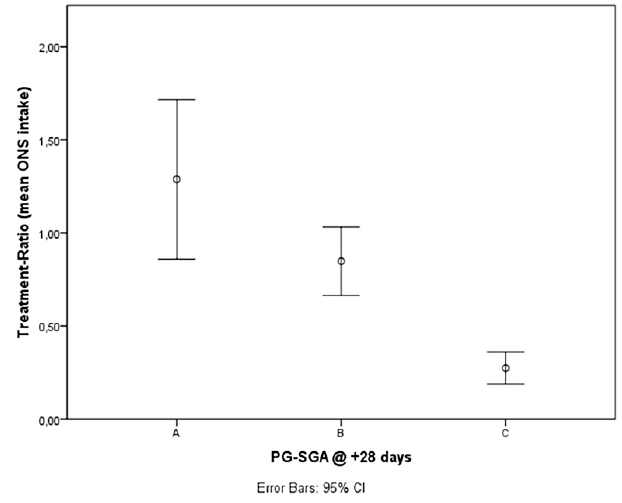
Figure 2. Mean TE-OPF assumption and malnutrition categories according to PG-SGA at 28 days after transplant (A = 129%, B = 85%, C = 27%, difference between A and B, p = 0.045, difference between A + B and C, p = 0.000; Mann–Whitney Test).